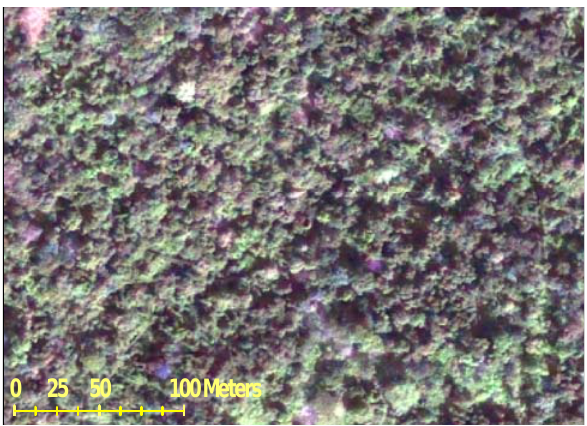
Figure1. IKONOS image of the part of study area The plot centres were located on IKONOS images and estimates of the amounts of timber volume, average stand height and average crown diameter were made on each plot with the help of standard volume tables. The extent of relationship among these three variables is given in Figures 2, 3 and 4. Average stand height (variable x) has greater correlation (r=0.794) with timber volume estimates than the average crown diameter (variable z; r=0.718). The estimates could be made rapidly when images were viewed stereoscopically. This method is definitely much faster and cost effective than the traditional field inventories.